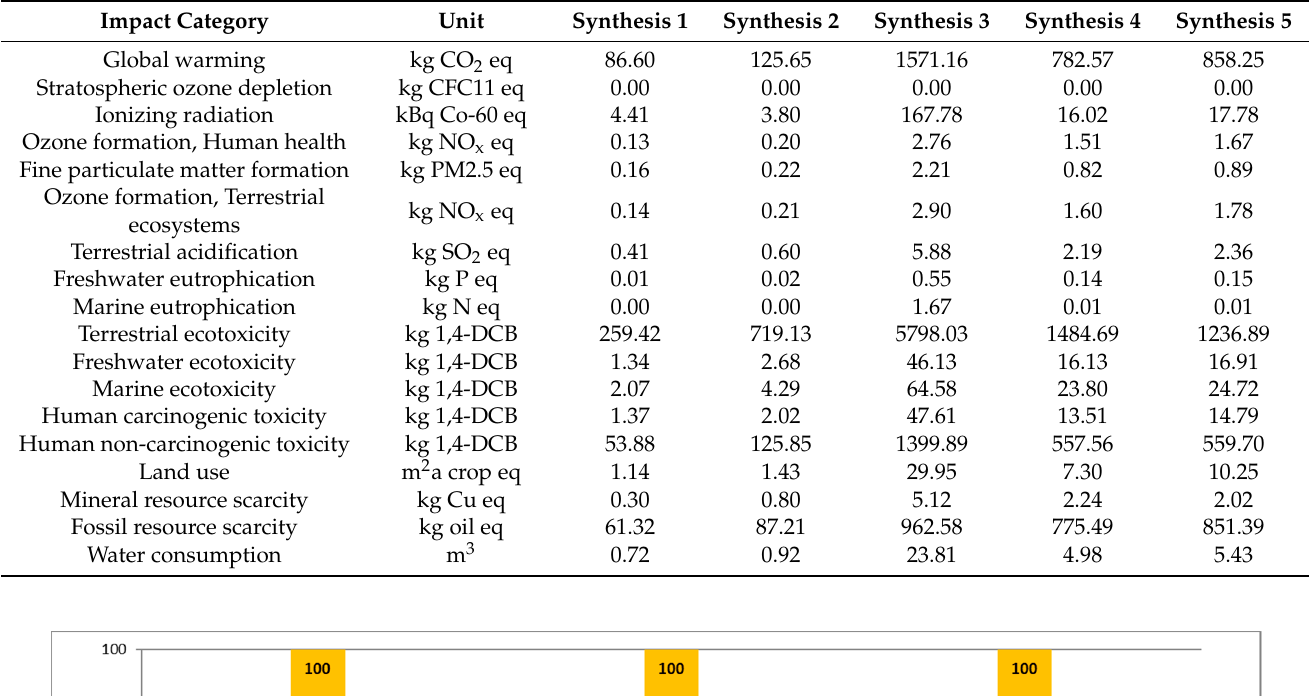
Table 2. Life Cycle Assessment of five different synthetic routes to produce ZIF-8.